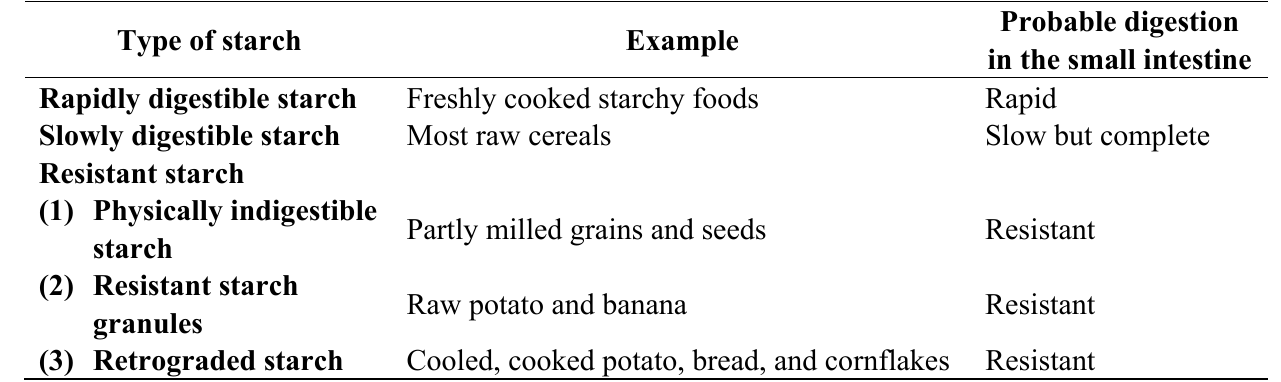
Table 2. Classification of naturally occurring starch (adapted from